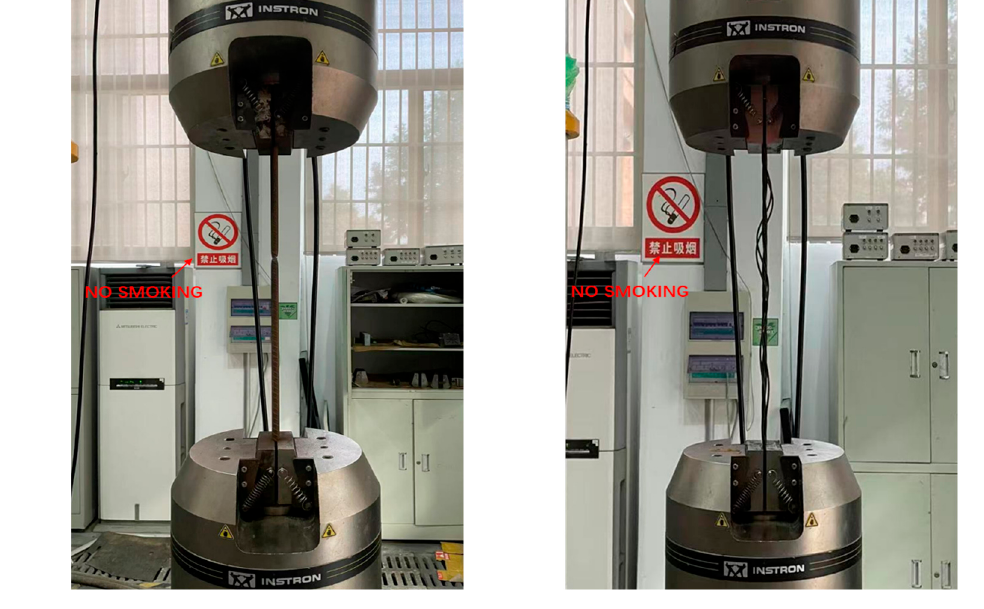
Figure 3. Tensile strength test of steel strand. Table 2. Reinforcement material parameters.